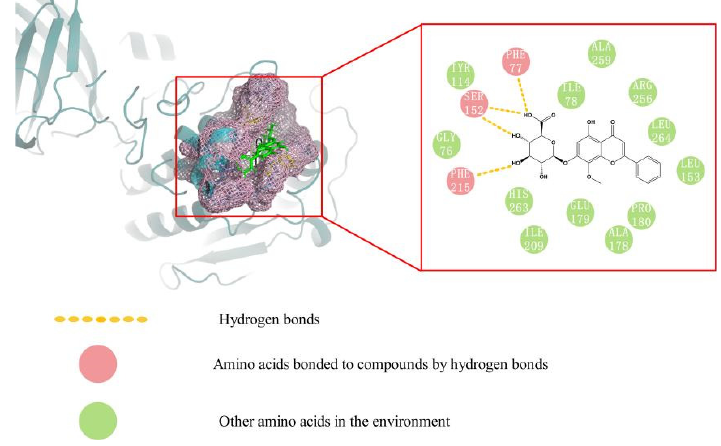
Figure 9. Molecular docking model diagram of wogonoside.